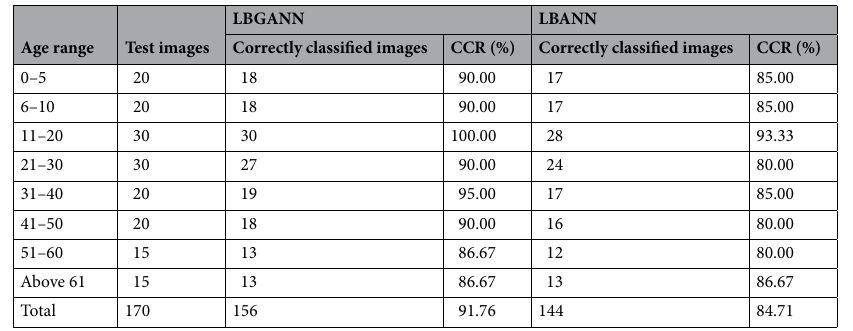
Table 3. Correct classification rate of LBGANN and LBANN.